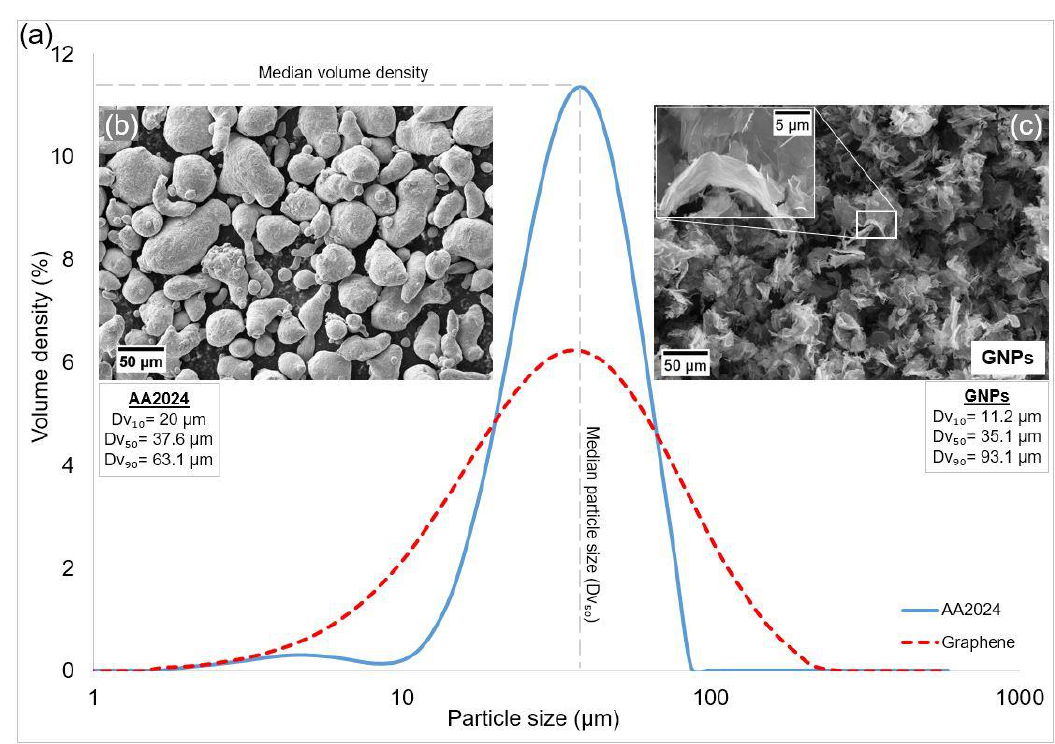
Figure 1. ( a ) The PSD of the alloy and Gr, ( b ) SEM images of the as-received (0 h) powder and ( c ) GNPs.